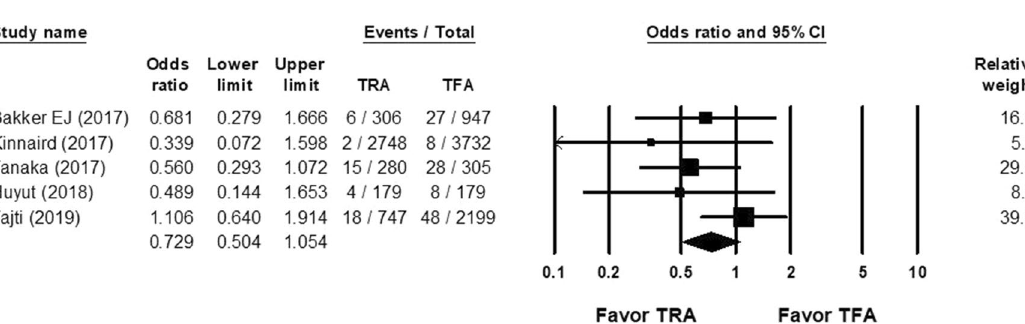
Figure 6. Forest plots of the OR of major adverse cardiovascular event rate of CTO PCI between the TRA and TFA groups from 5